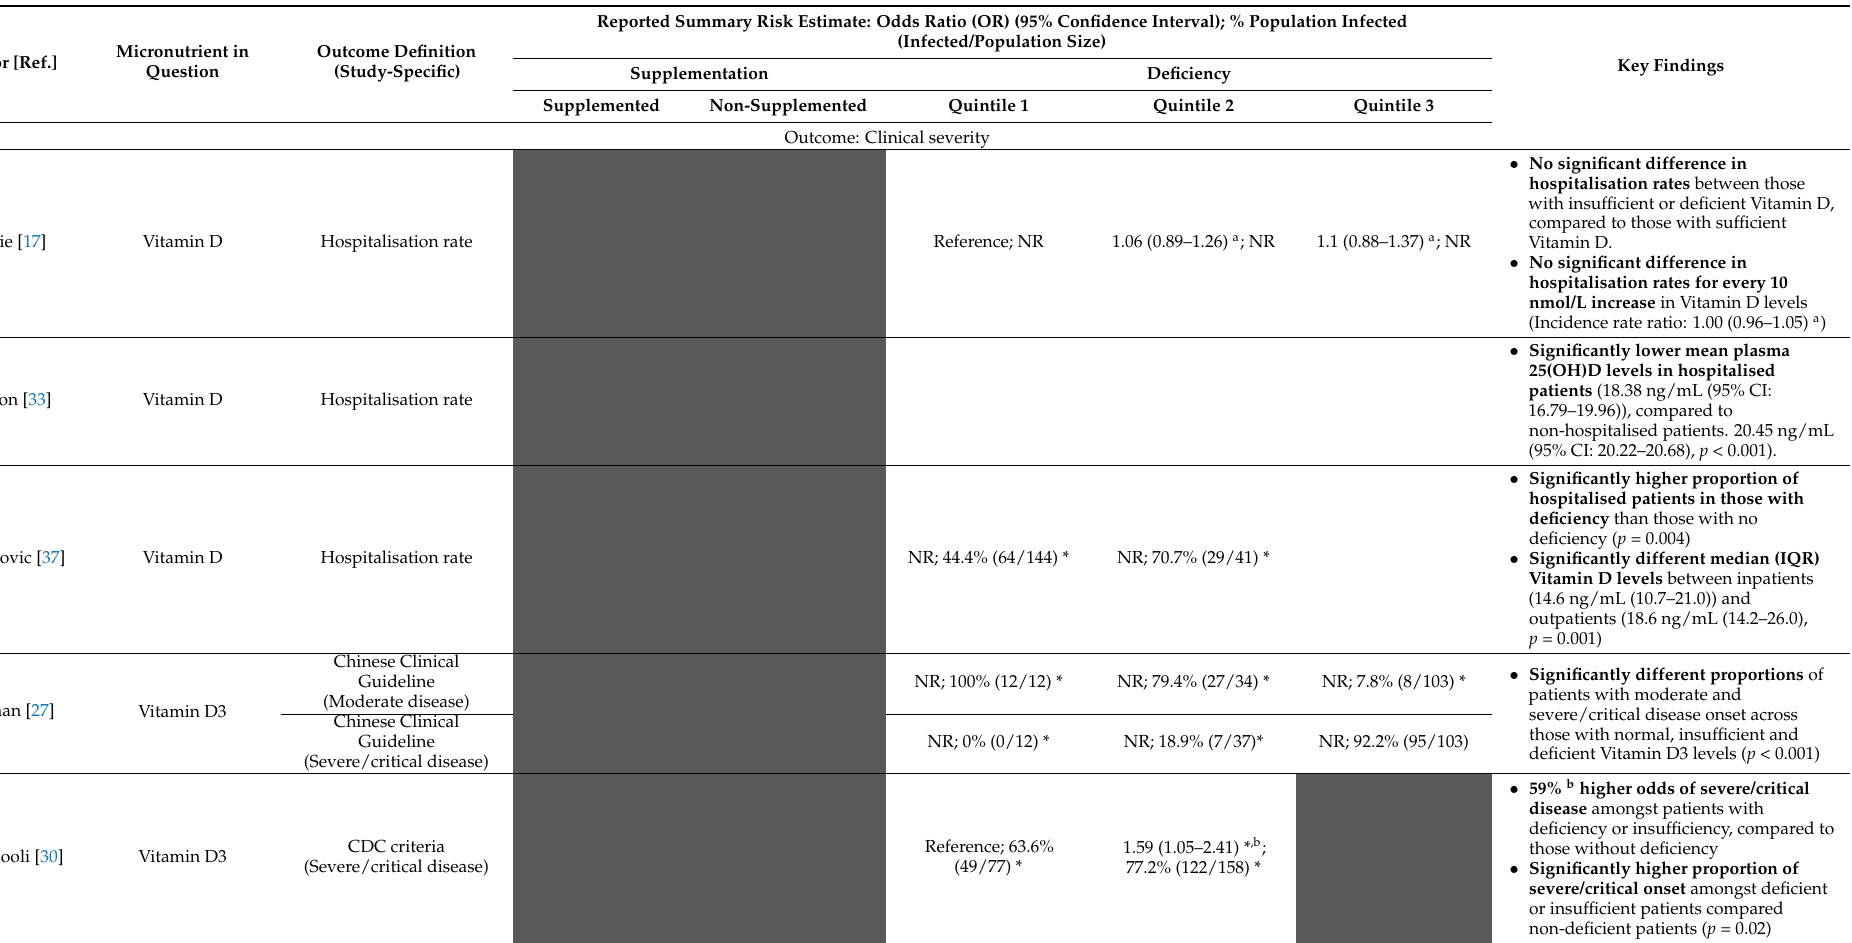
Table 5. COVID-19 Severity indicated by outcomes with study-specific